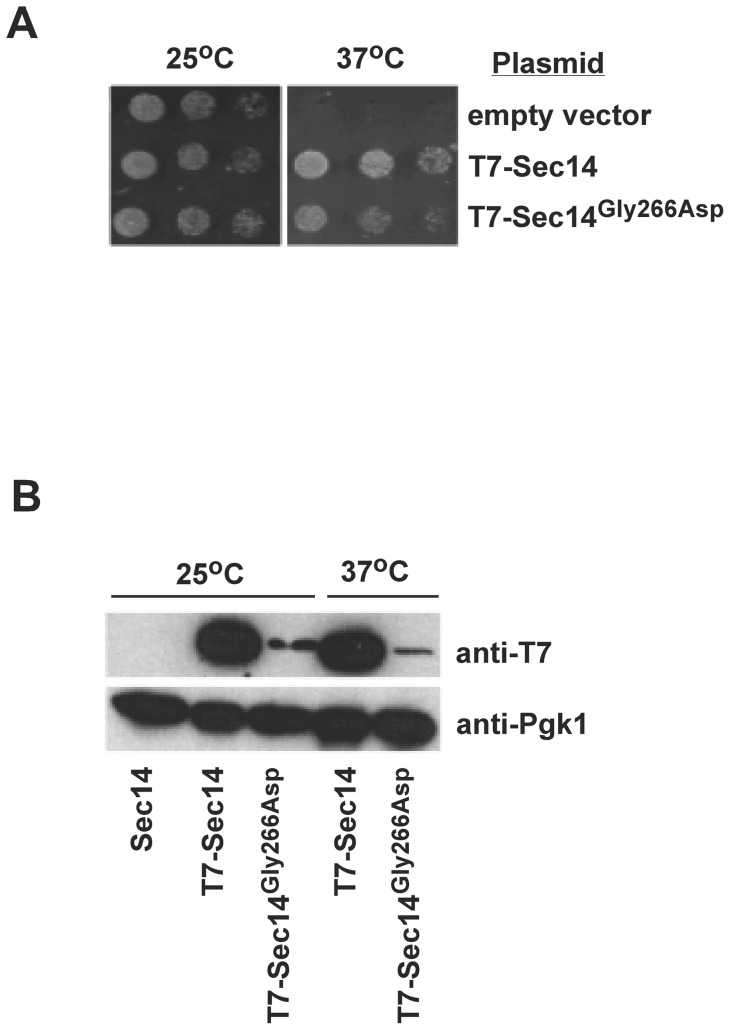
Effect of temperature on Sec14 and Sec14 G266D protein levels.
A, the sec14ts cells were transformed with a plasmid expressing Sec14 containing an N-terminal T7 epitope, untagged Sec14, or empty vector. SEC14 expression was driven by the constitutive GPD1 promoter. Cells were grown in solution at 25°C to mid-logarithmic phase, and serial dilutions of identical numbers of cells were spotted onto plates and incubated at 37°C for two days. B, cells expressing T7-Sec14 or Sec14G266D were grown to mid-logarithmic phase at 25°C, with a subset shifted to 37°C for 2 hrs. Cells were disrupted by three passes through a French press and membranes were separated from soluble proteins by differential centrifugation. Proteins in each fraction were separated by SDS-PAGE, transferred to PVDF membrane, and western blots were performed. In the blots shown 10 fold more protein extract was loaded in each Sec14G266D lane compared to extracts containing wild type Sec14 for blots versus the T7 epitope due to protein expression level differences.